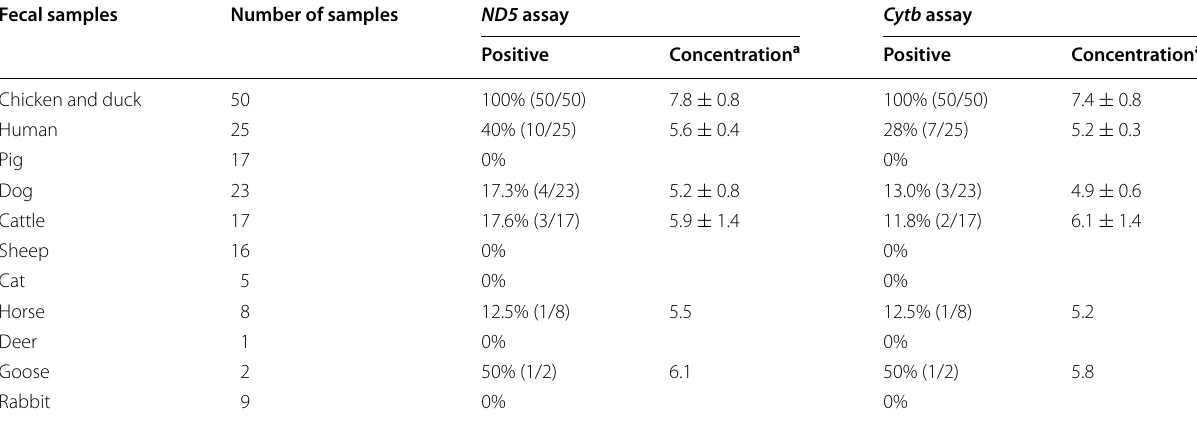
a Concentrations are expressed as log10 copies per g dry feces